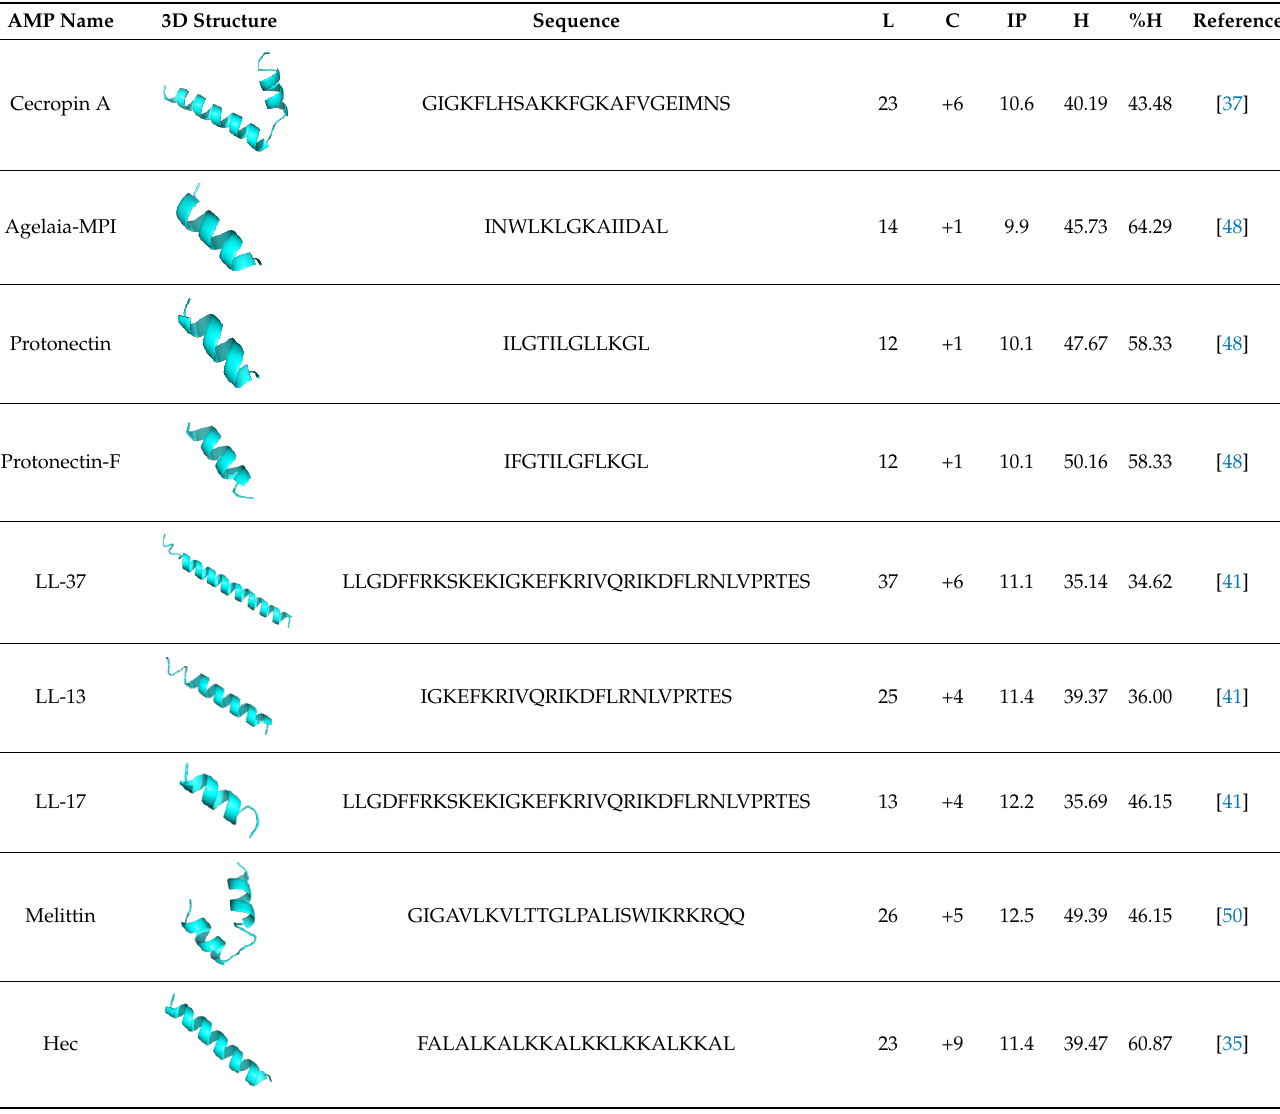
Table 5. Structural and physicochemical properties of AMPs that showed antibacterial activity against VRSA and VISA